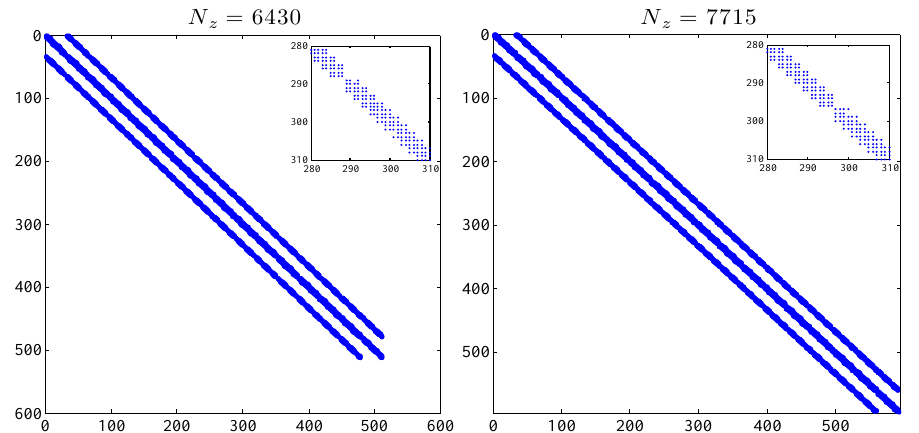
Figure 3. Matrix sparsity patterns for the four different mesh types shown in Figure 2 for N x = 15 with N z the number of non-zero elements.